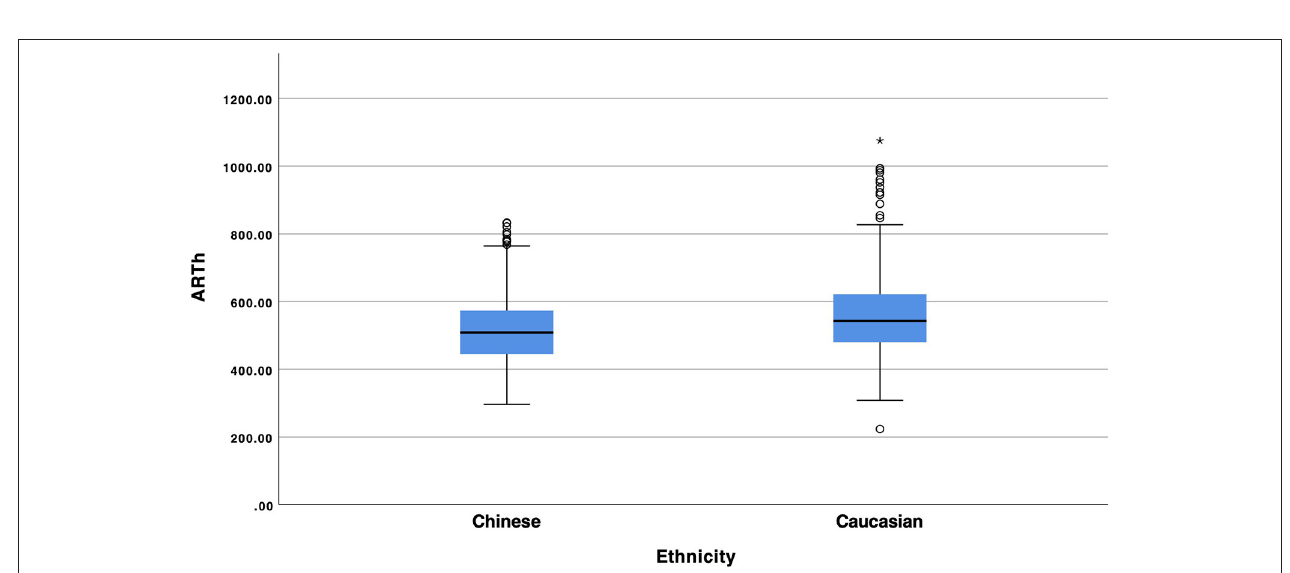
FIGURE 2 | Box and whiskers plot of Arth of Chinese and Caucasian population.